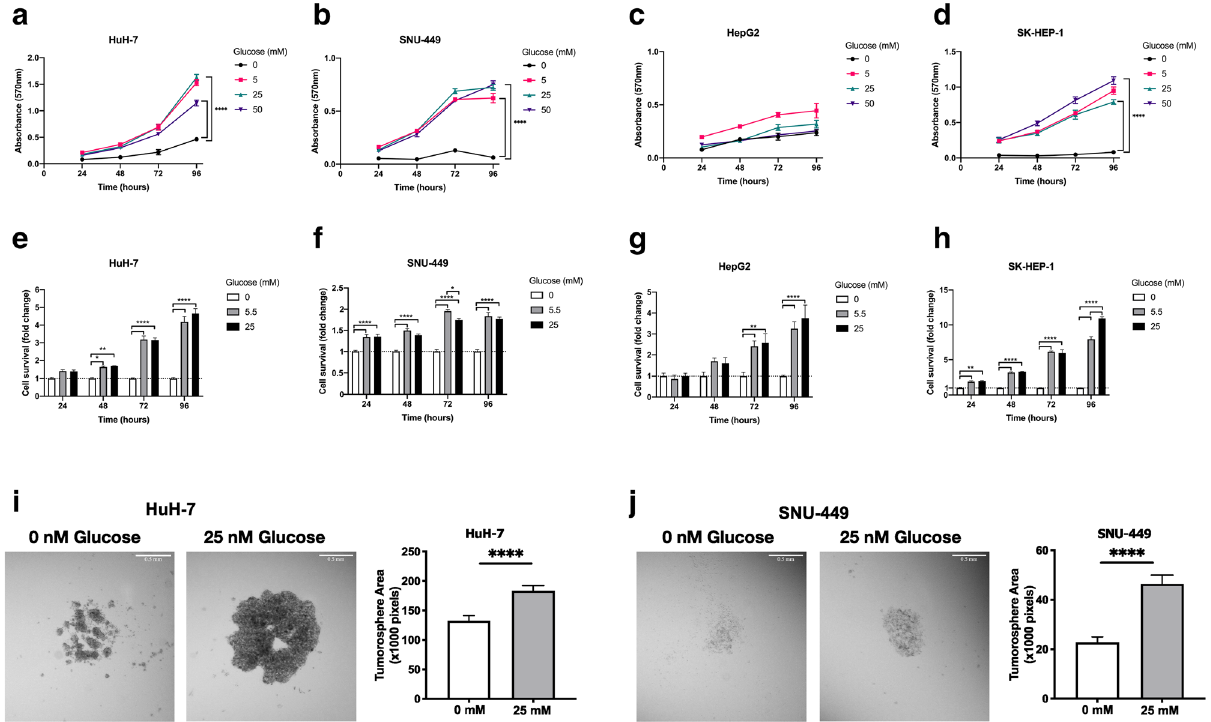
Figure 2. High glucose did not induce glucose toxicity but enhanced spheroid formation in HCC cells. Analysis of toxicity of ( a ) HuH-7, ( b ) SNU-449, ( c ) HepG2 and ( d ) SK-HEP-1 cells in response to increasing glucose concentrations (0, 5, 25, 50 mM) with MTT assay. Cell survival is represented as absorbance (570 nm). Analyses of cell survival differences of ( e ) HuH-7, ( f ) SNU-449, ( g ) HepG2 and ( h ) SK-HEP-1 cells in no-, normo- (5.5 mM) and hyperglycemic-glucose (25 mM) conditions by SRB. Brightfield images and graphical presentation of hanging-drop spheroid formation assay performed with ( i ) HuH-7 and ( j ) SNU-449 cells in no- and high- glucose (25 mM glucose) supplemented conditions. Spheroid area is calculated with ImageJ. All graphs of experiments are presented as the mean ± SEM of at least 3 independent experiments. Statistical analyses were performed and graphs were generated using GraphPad Prism version 8.2.1 for MacOS, GraphPad Software, San Diego, California USA, https:// www. graph pad. com. * p ≤ 0.05, ** p ≤ 0.01, *** p ≤ 0.001, **** p ≤